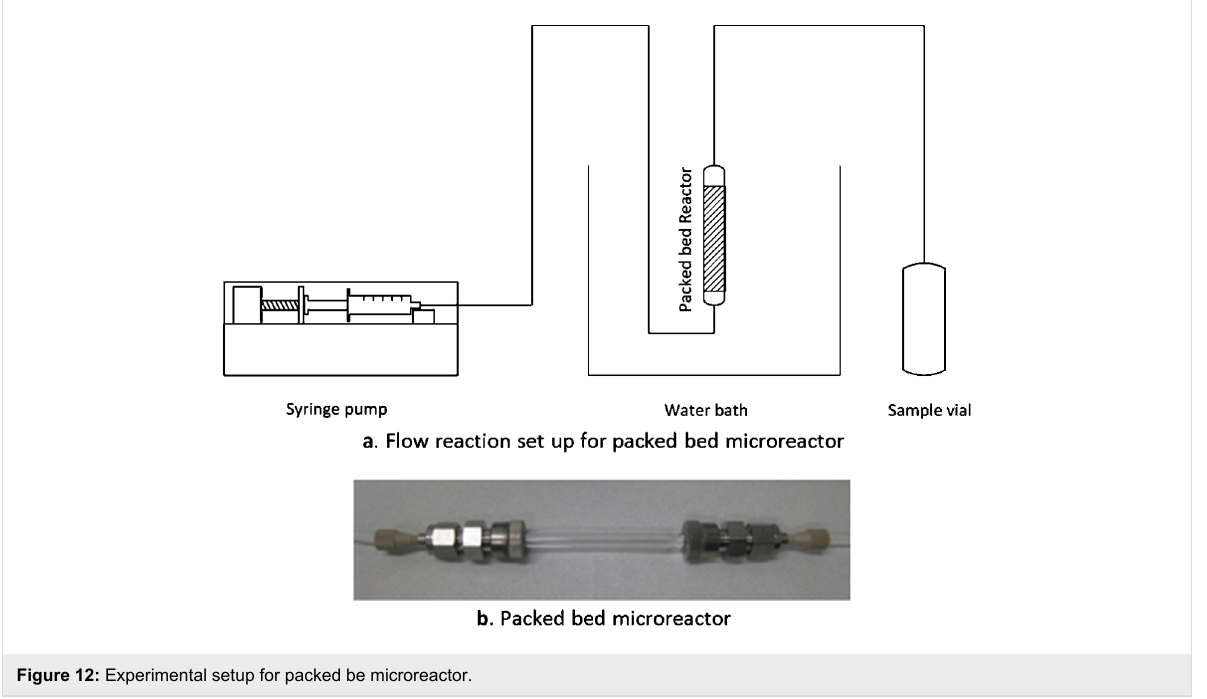
Figure 12: Experimental setup for packed be microreactor.